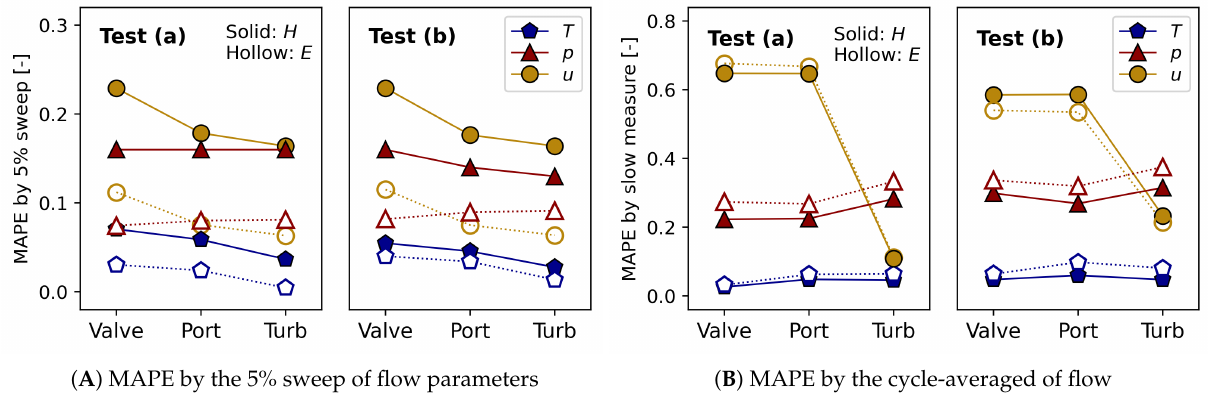
Figure 13. MAPE for enthalpy and exergy rates at test points. The solid markers represent enthalpy, and the hollow markers denote exergy.